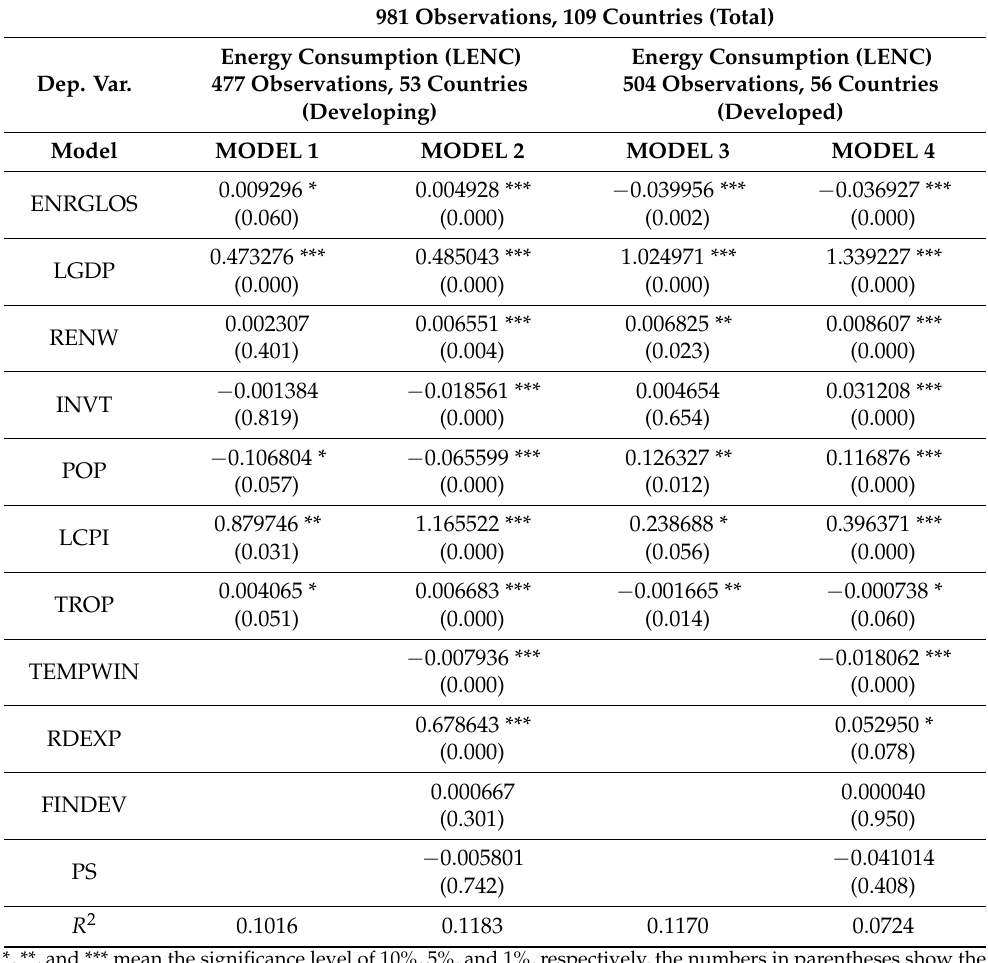
Table 7. Distinguishing developing and developed countries. FMOLS estimation